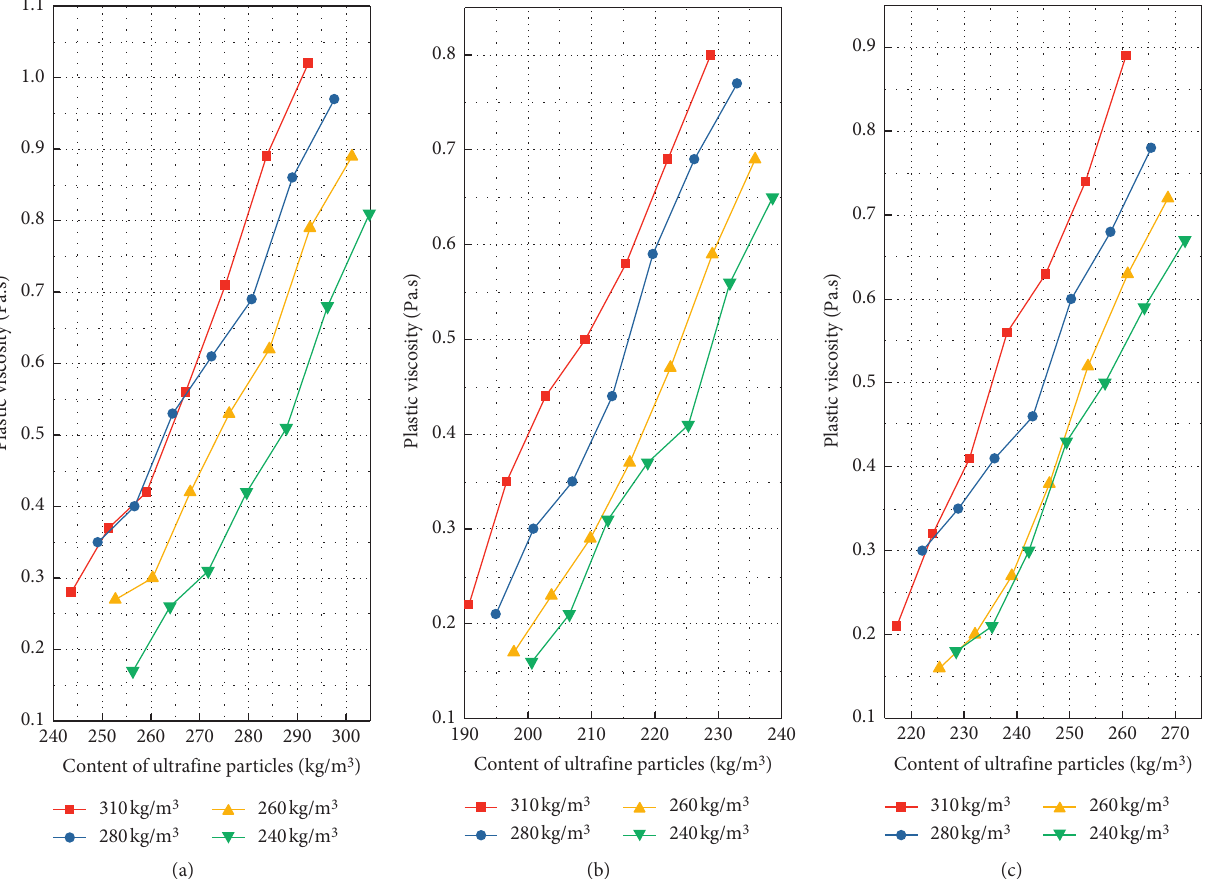
Figure 8: Relationship between the ultrafine tailing content and plastic viscosity under different gradations. (a) Waste rock :desert sand � 5: 5. (b) Waste rock:desert sand � 6: 4. (c) Waste rock:desert sand � 7: